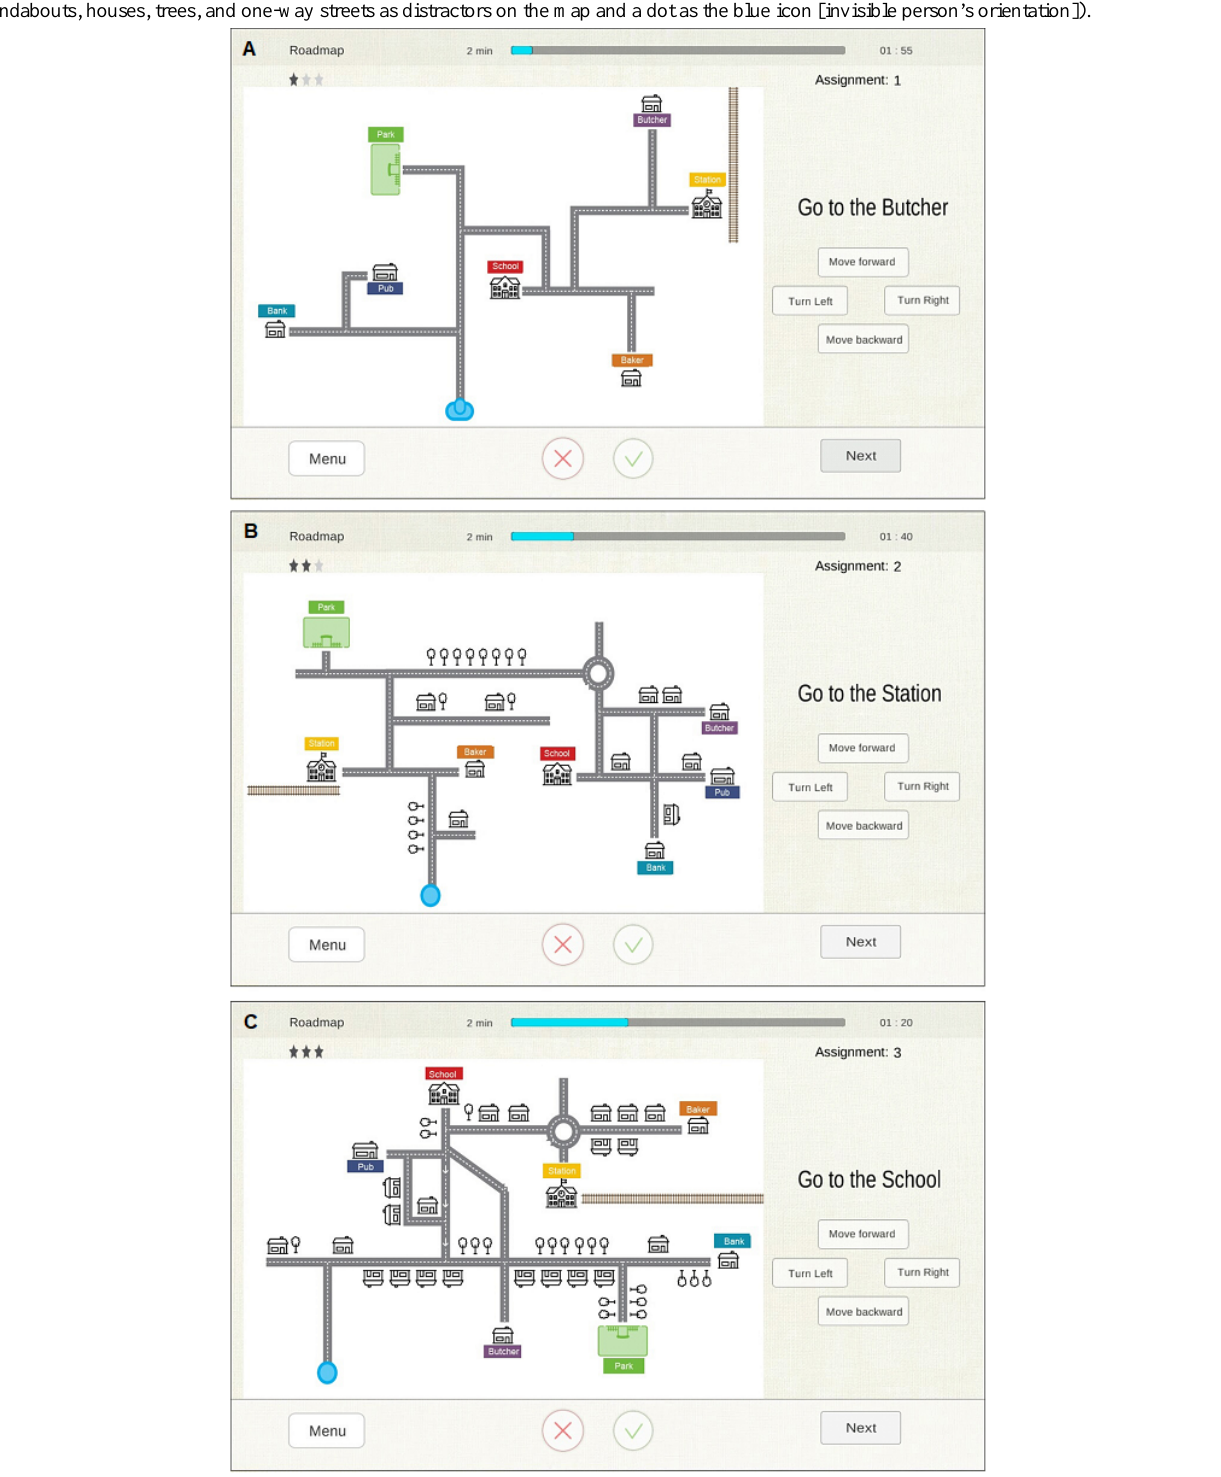
Figure 4. Roadmap exercise. (A) Low difficulty level (without map distractors and with a head as the blue icon to help with orientation); (B) medium level (with roundabouts, houses, and trees as distractors on the map and a dot as the blue icon [invisible person’s orientation]); (C) high level (with roundabouts, houses, trees, and one-way streets as distractors on the map and a dot as the blue icon [invisible person’s